Question: What type of chart is this?
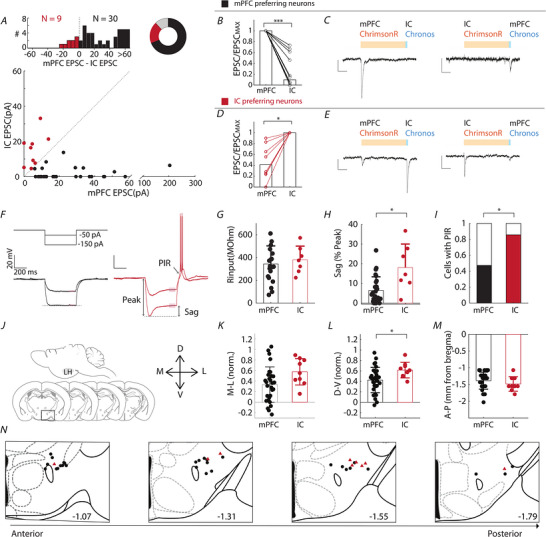
Answer: histogram